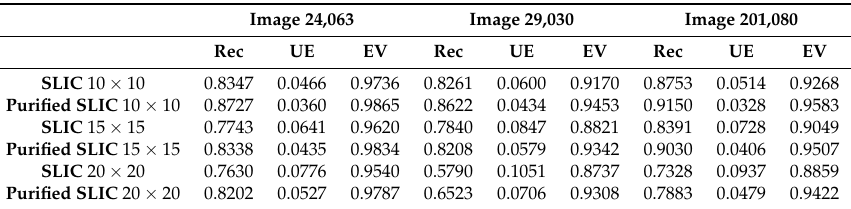
Table 1. Evaluation metrics for